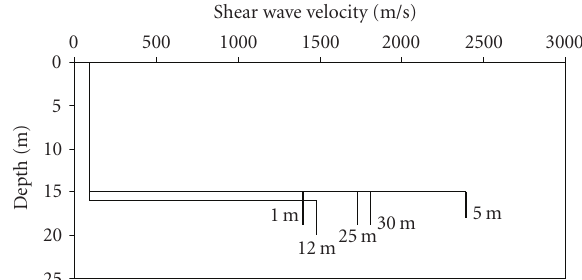
Figure 5: Layer models of depth-shear wave velocity for NRC site. Shear wave velocity profiles for di ff erent bedrock depth of the initial model, shown at the end of each profile. Contrast ratio and average soil velocity values are